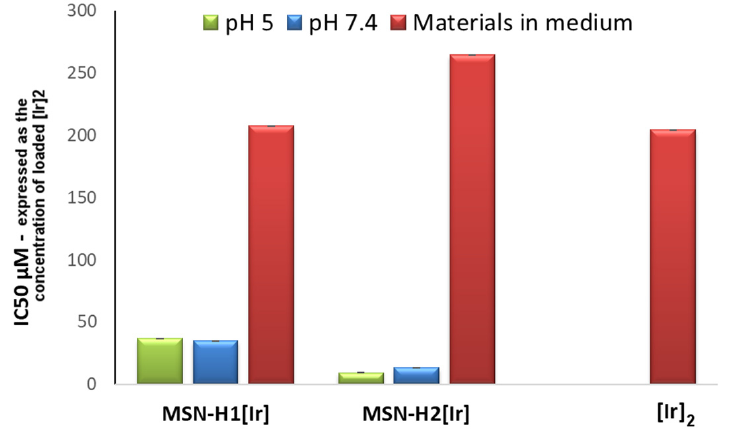
Figure 6. Comparison of the IC 50 by taking into account the amounts of loaded [Ir] 2 complex on the materials and expressing the results in the micromolar ( µ M) concentration of the loaded [Ir] 2 complex on the materials needed to inhibit the cell viability by 50%.